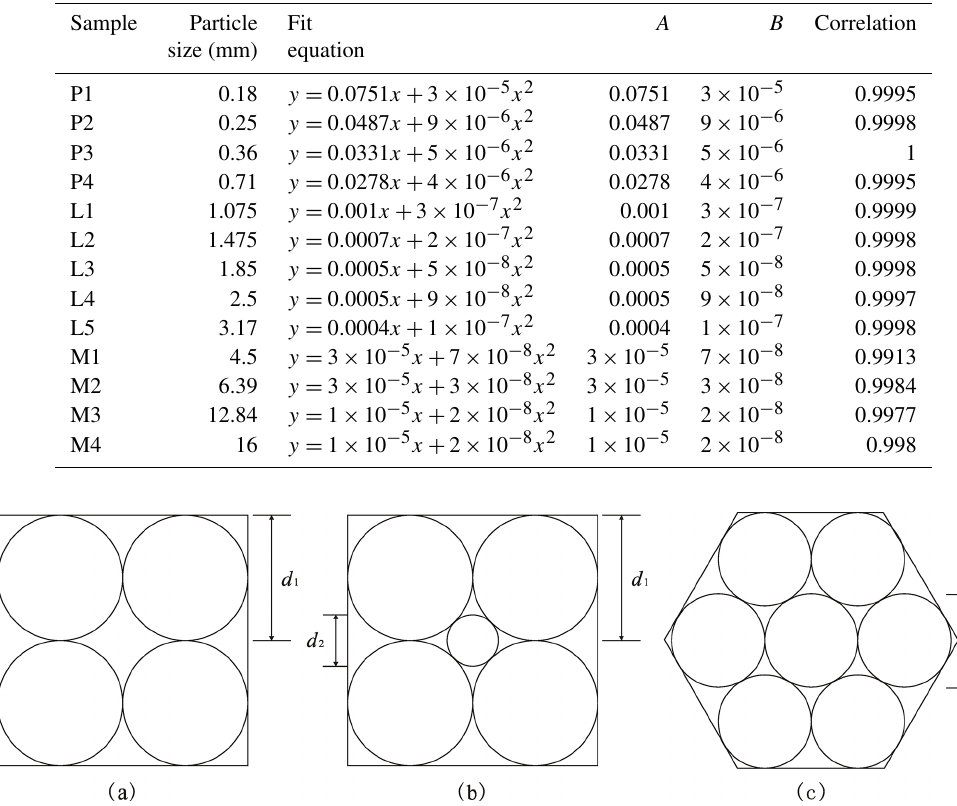
Table 5. Experimental fitting coefficients of different homogeneous particles sizes.